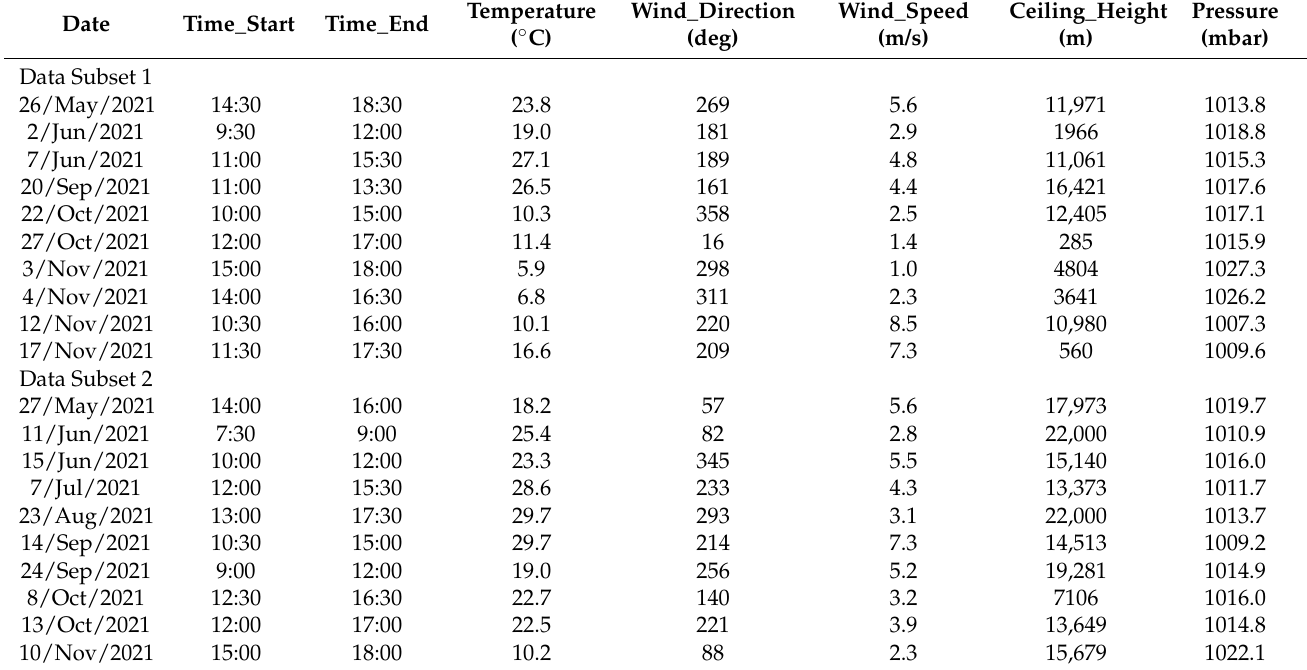
Table 1. Summary of sampling schedule (in local time, EST) and meteorological conditions of the 20 days in the two data subsets. Meteorological variables represent the average (circular average for wind direction and scalar average for the rest parameters) for the study period derived from data from four local airports (measured at 10